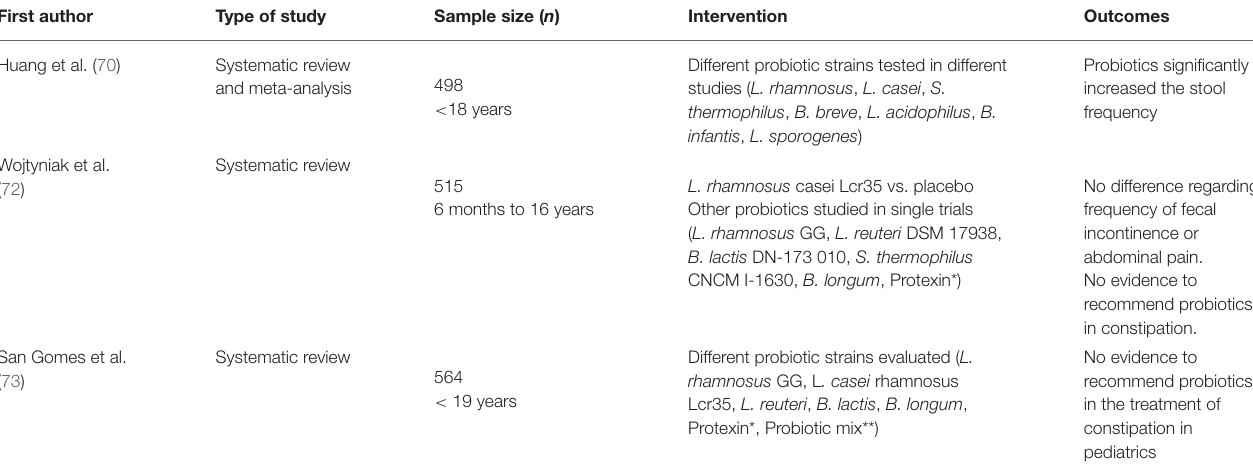
TABLE 3 | Constipation.